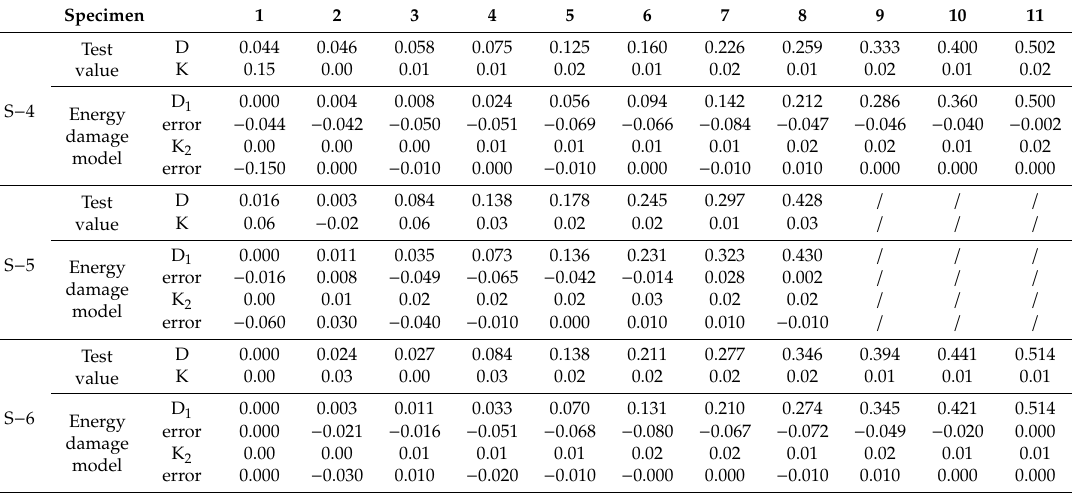
Table 4. Comparison of damage models and experimental results.